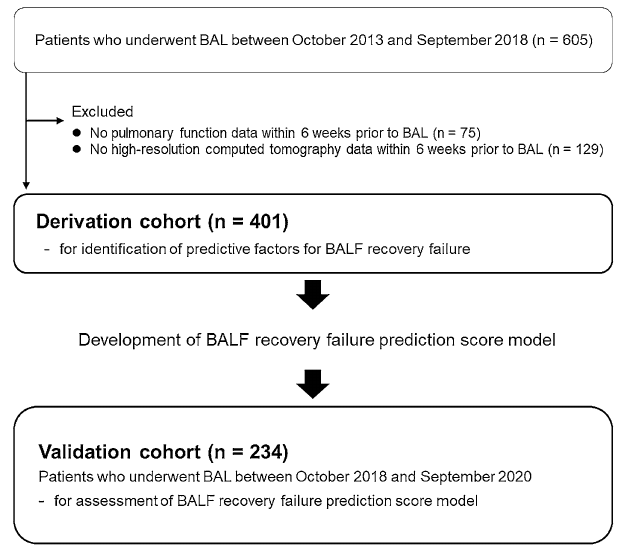
Figure 1. Study flow chart. BAL bronchoalveolar lavage, BALF BAL